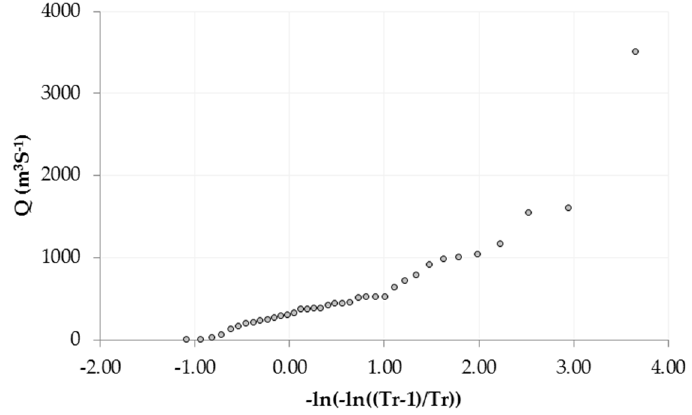
Figure 3. Reduced variable for maximum annual flows of hydrometric station 10031.